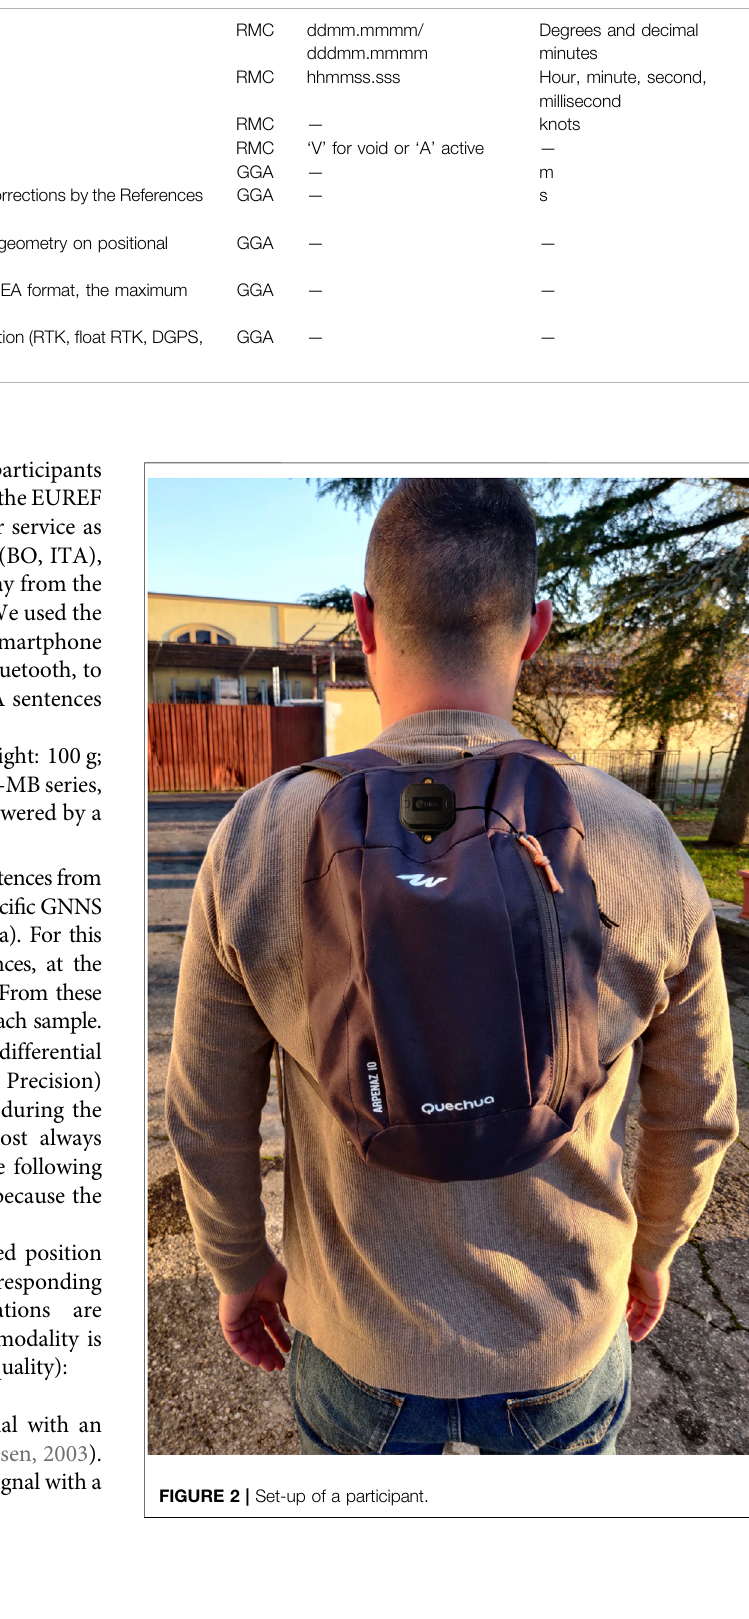
TABLE 1 | Data extracted from NMEA sentences. Description